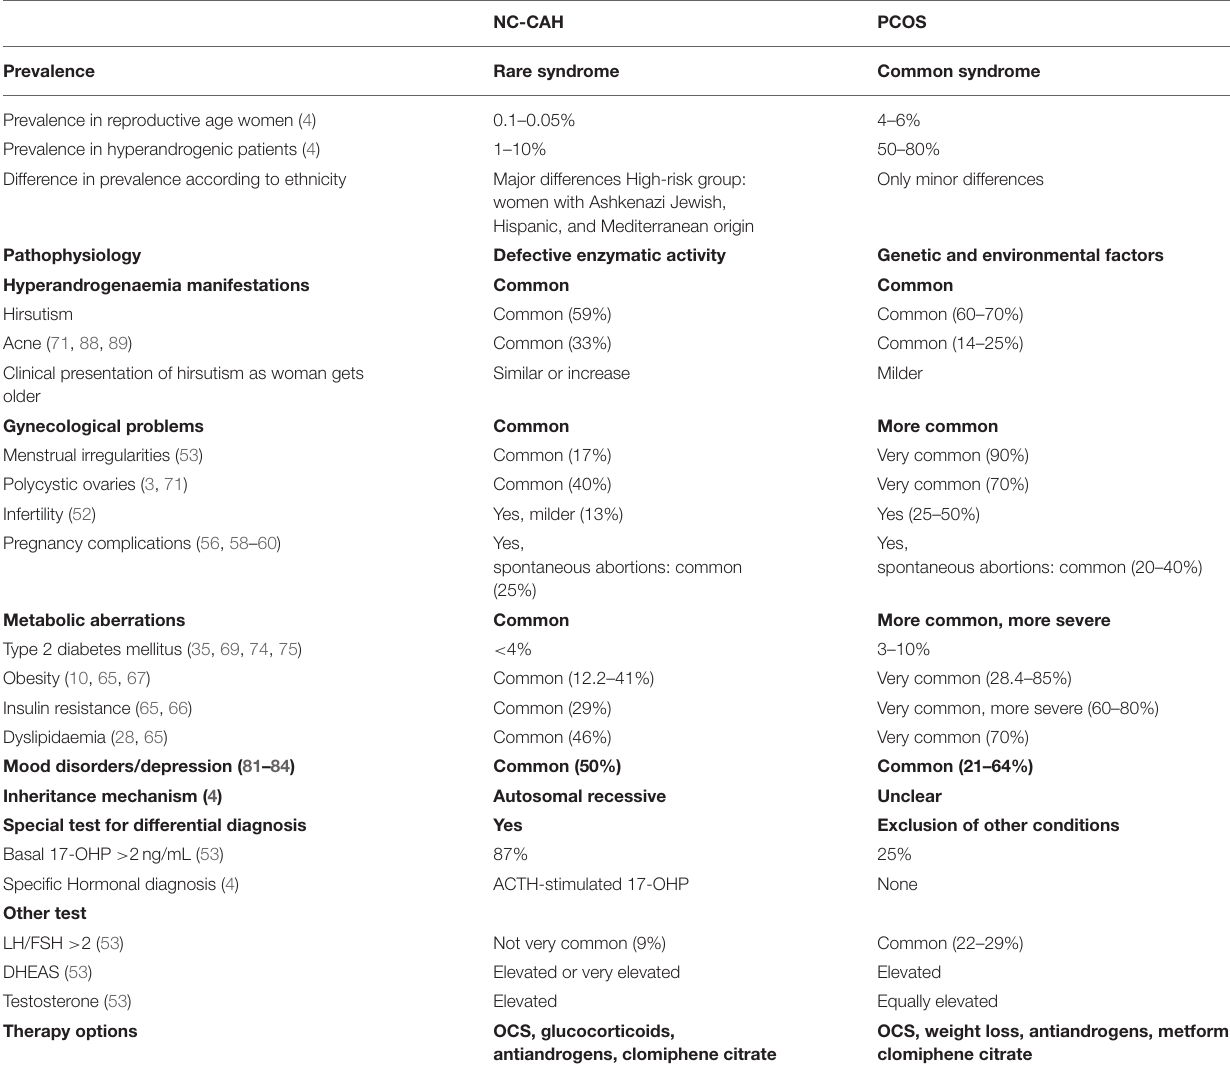
TABLE 1 | Common and different characteristics of the two